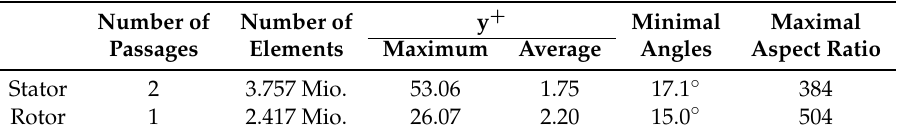
Table 1. Topology and mesh